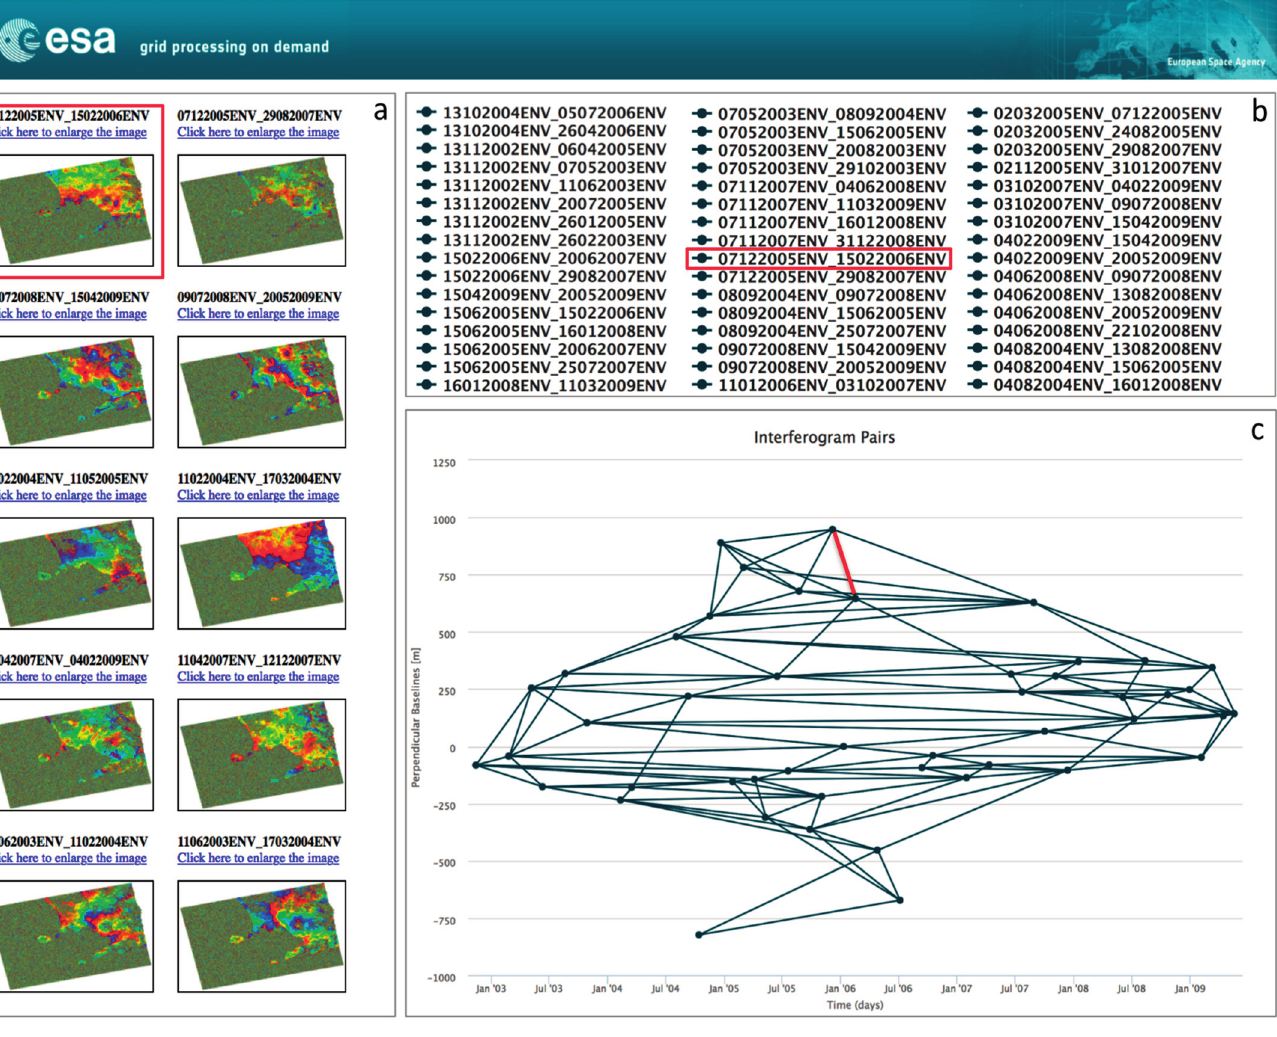
Figure 5. Web interface for the interferograms selection. ( a ) Quick looks of the inteferograms generated by the P-SBAS web tool (the example is relevant to the ENVISAT data over Napoli Bay area, see Figure 2). One selected interferogram is highlighted via red square, ( b ) List of the interferometric pairs with, highlighted, the same interferogram considered in Figure 5a, and ( c ) distribution of the interferometric pairs in the temporal (x-axis) vs. spatial baseline (y-axis) plane. Additionally, in this case the same interferogram considered in Figure 5a is